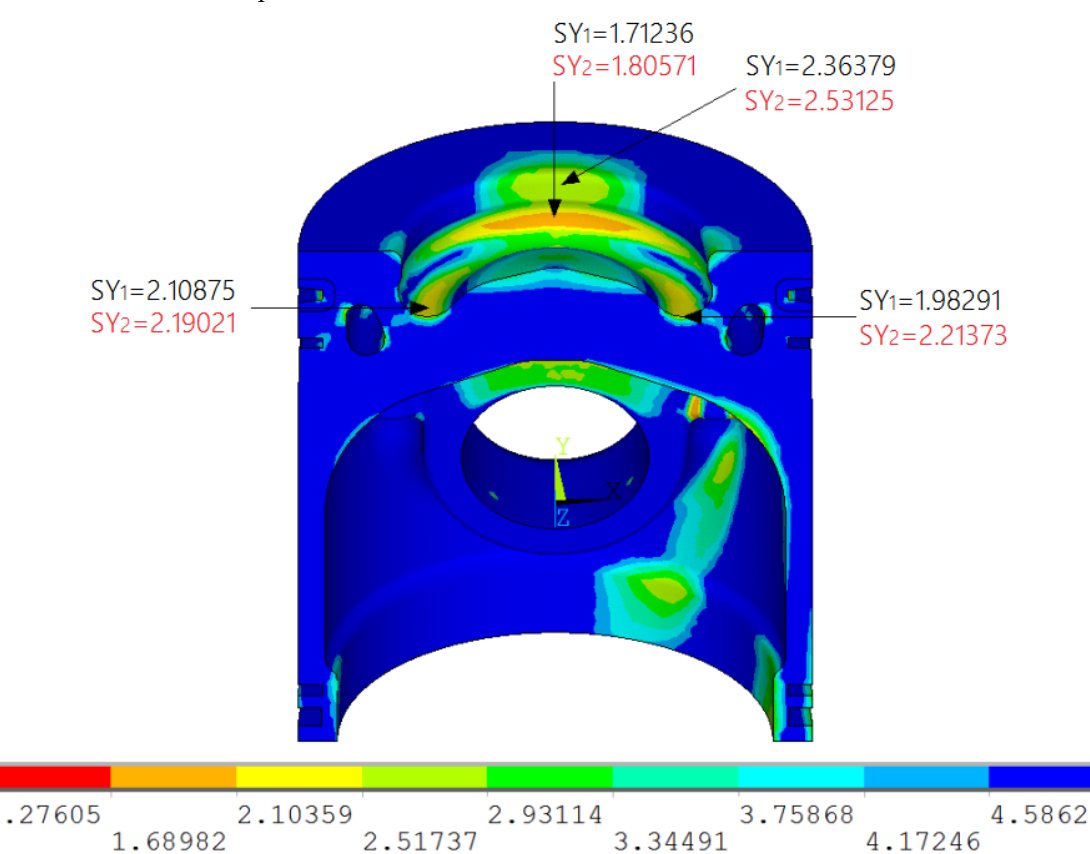
Figure 7. Fatigue safety factor of key parts for the piston under the two schemes.